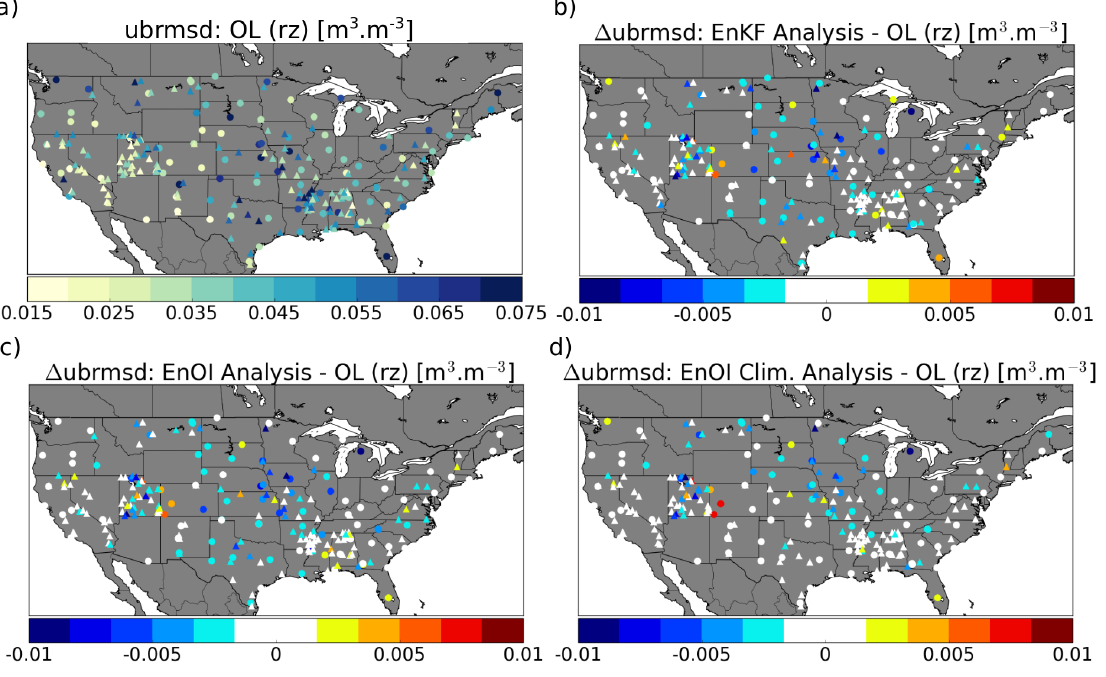
Figure 9. ( a ) unbiased root mean square difference (ubrmsd, m 3 m − 3 ) between the ensemble open-loop (eOL) root-zone soil moisture and the SCAN (triangles) and USCRN (circles) stations. Yellow/blue colours indicate low/high ubrmsd; ( b ) ∆ ubrmsd (EnKF minus eOL), blue/red colours indicate positive/negative impact of the analysis (148 of 223 stations improved); ( c ) ∆ ubrmsd (EnOI minus eOL) (127 of 223 stations improved); ( d ) ∆ ubrmsd (EnOI-Clim minus eOL) (130 of 223 stations